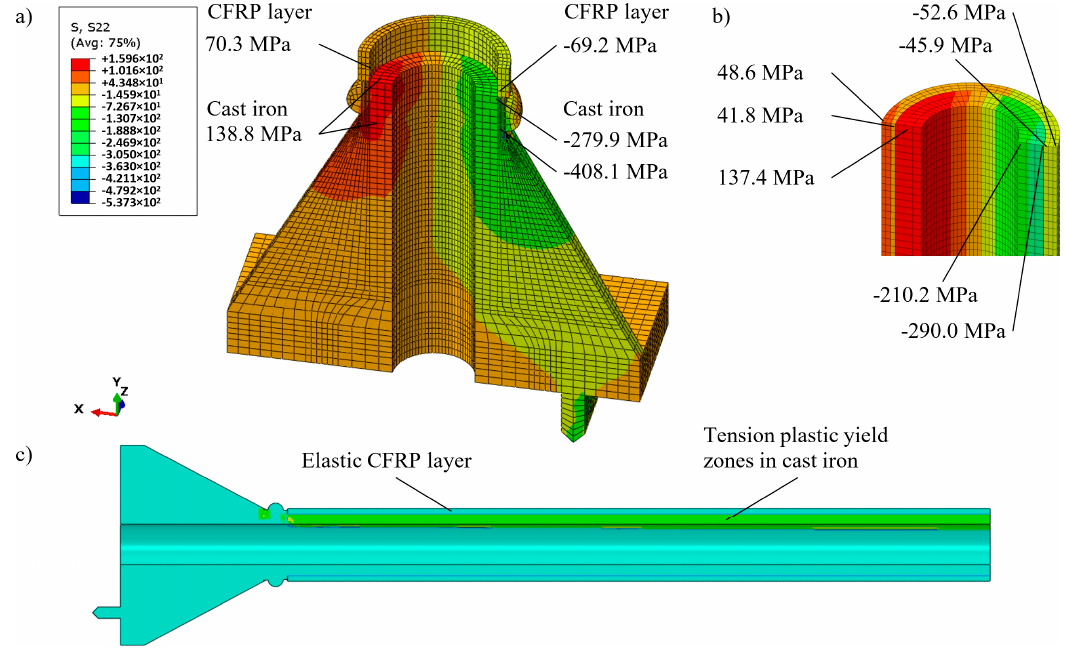
Figure 12. Nonlinear two-stage strengthening column analysis: ( a ) Distribution of the longitudinal stresses for N = 192 kN; ( b ) longitudinal stresses at the middle section of the column, ( c ) tensile plastic yield zones.